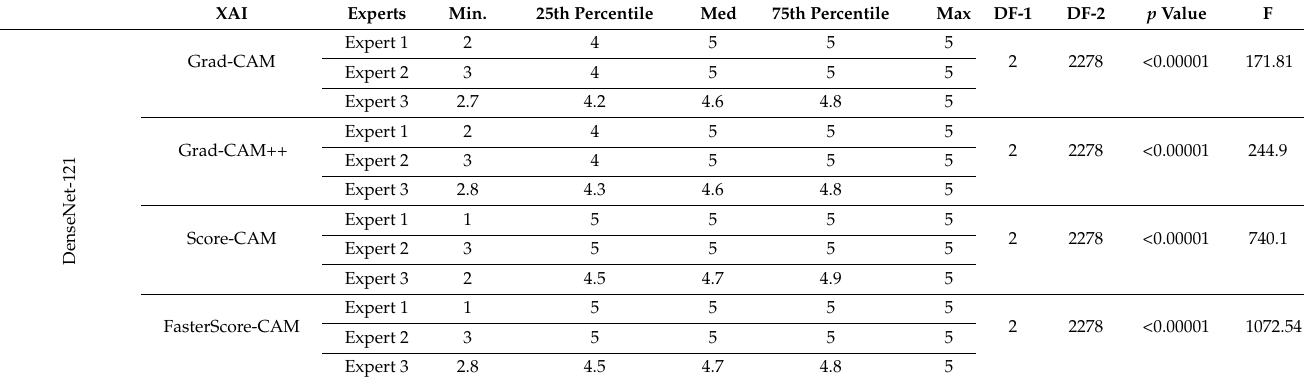
Figure A1. ResNet-UNet architecture. Table A1. Friedman test using DenseNet-121 model on the MAI score from three experts.